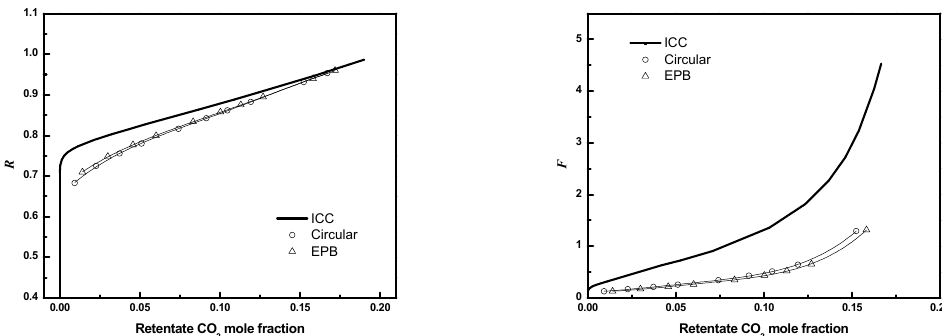
Figure 20. R or F as a function of CO 2 mole fraction for full 3-D circular module and EPB module ( N = 405, D / R f = 3, φ = 0.6. Circle, circular bundle; up triangle, EPB; solid line, ICC).